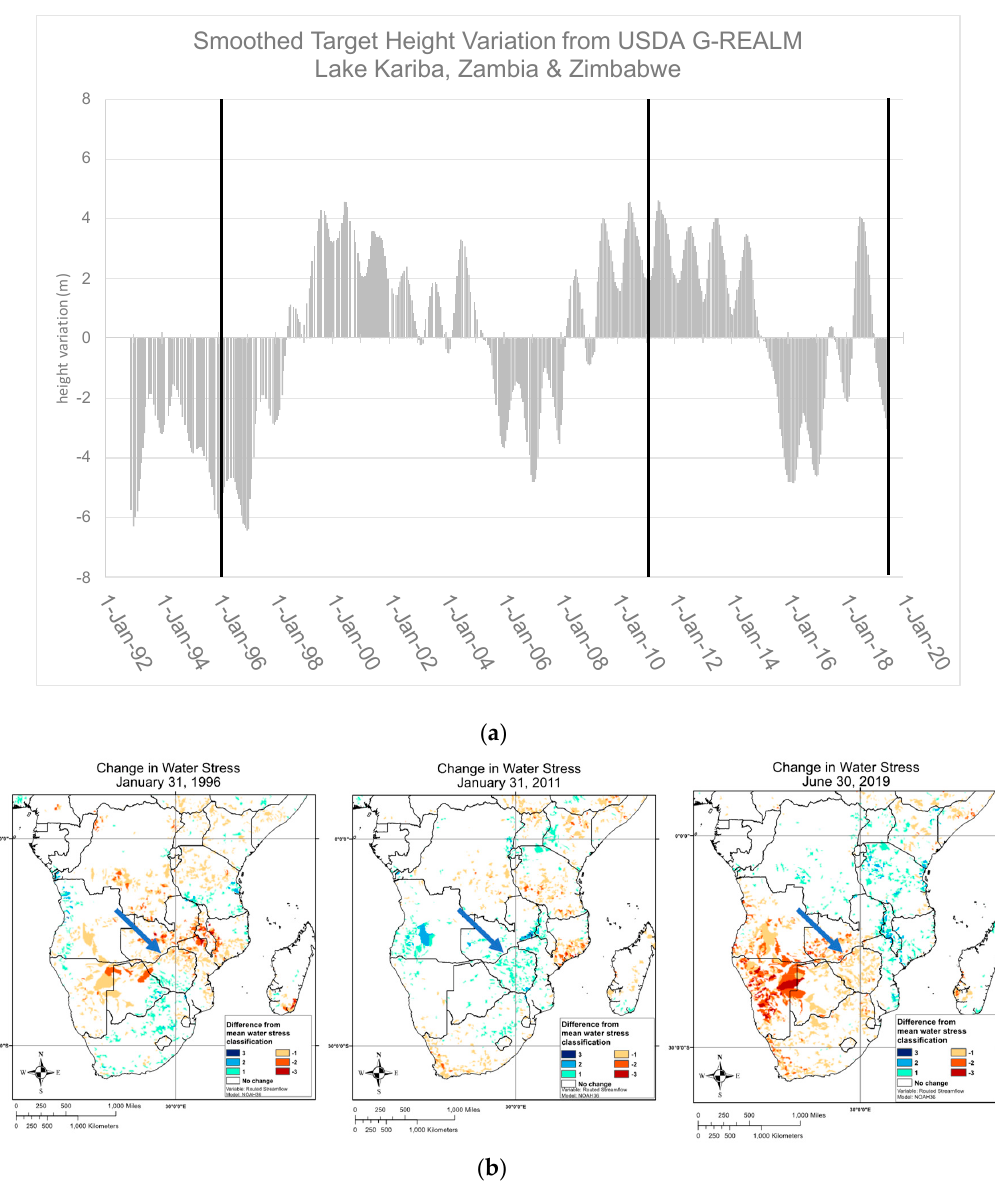
Figure 3. ( a ) US Department of Agriculture (USDA) Global Reservoir and Lakes (G-REALM) altimetry data for Lake Kariba, located on the border with Zambia and Zimbabwe, black lines denote dates shown in maps. ( b ) Maps of change in water stress class with respect to average. Blue arrow denotes location of Kariba Dam.